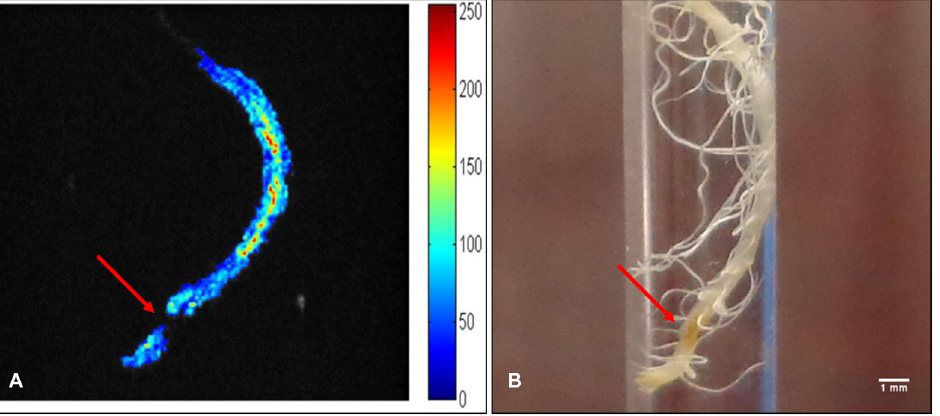
Figure 7. MRI image of rice root immersed in 5 mmol Gd-DTPA for 6 h (A). Aging or dead tissues is marked with arrows. Image B shows a photograph image of the root sample.